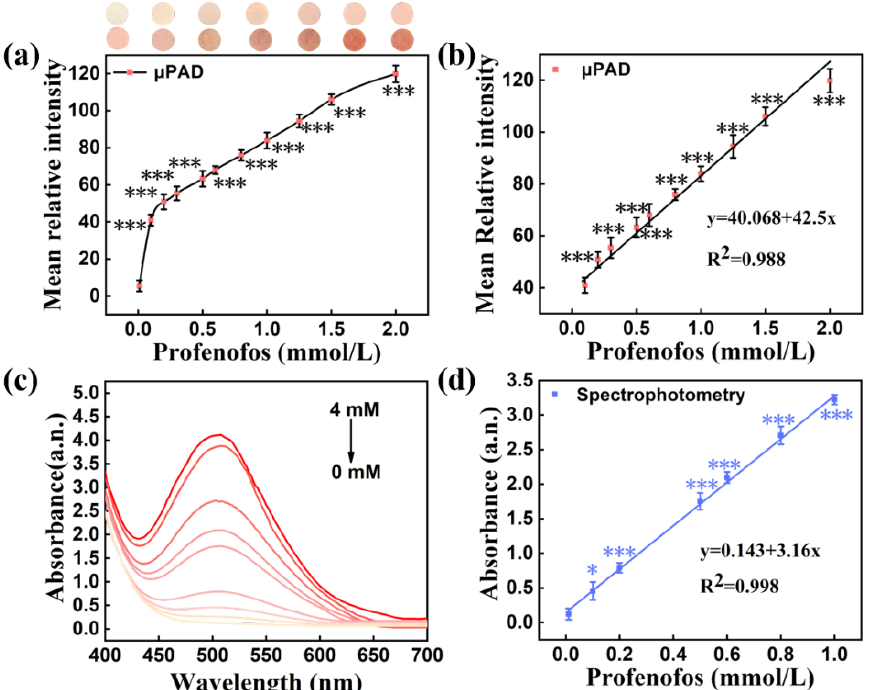
Figure 8. The effects of experimental conditions on pSBMA-μPAD and spectrophotometry: ( a ) the concentration of NaOH, ( b ) pH of system buffer, ( c ) the concentration of potassium ferricyanide and ( d ) the concentration of 4-aminoantipyrine. “*” stands for significance test.